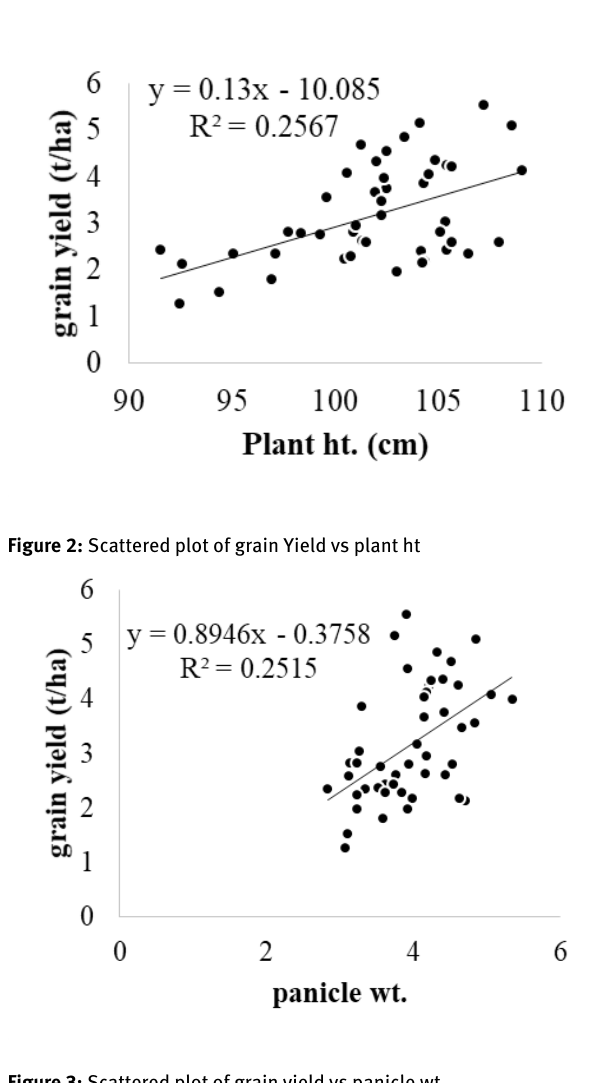
Figure 3: Scattered plot of grain yield vs panicle